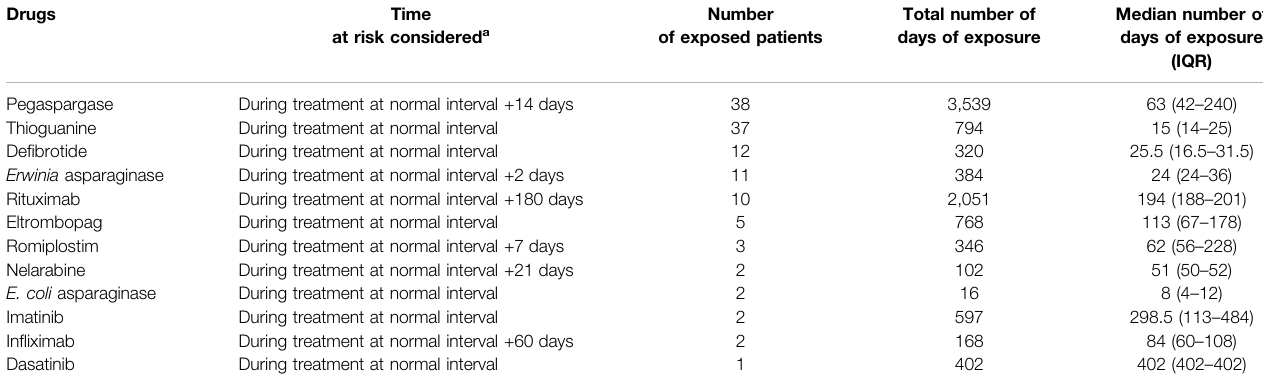
TABLE 2 | Exposure to study drugs.